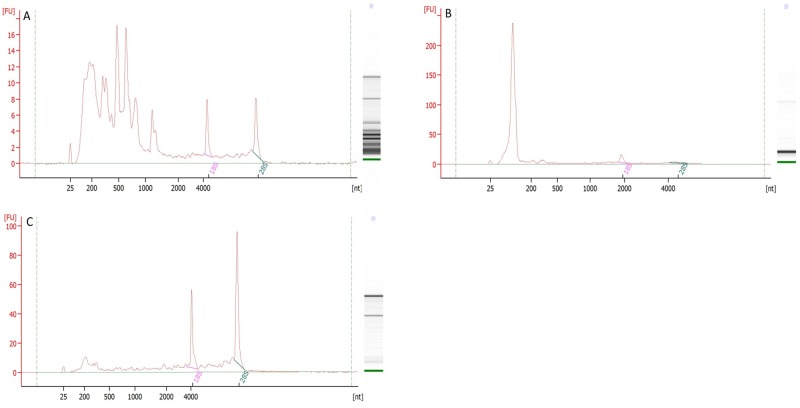
Total RNA capillary electrophoresis electropherograms from milk fractions on Bioanalyzer 2100 (cow No.12).(A) milk fat; (B) milk whey; and (C) milk cells.